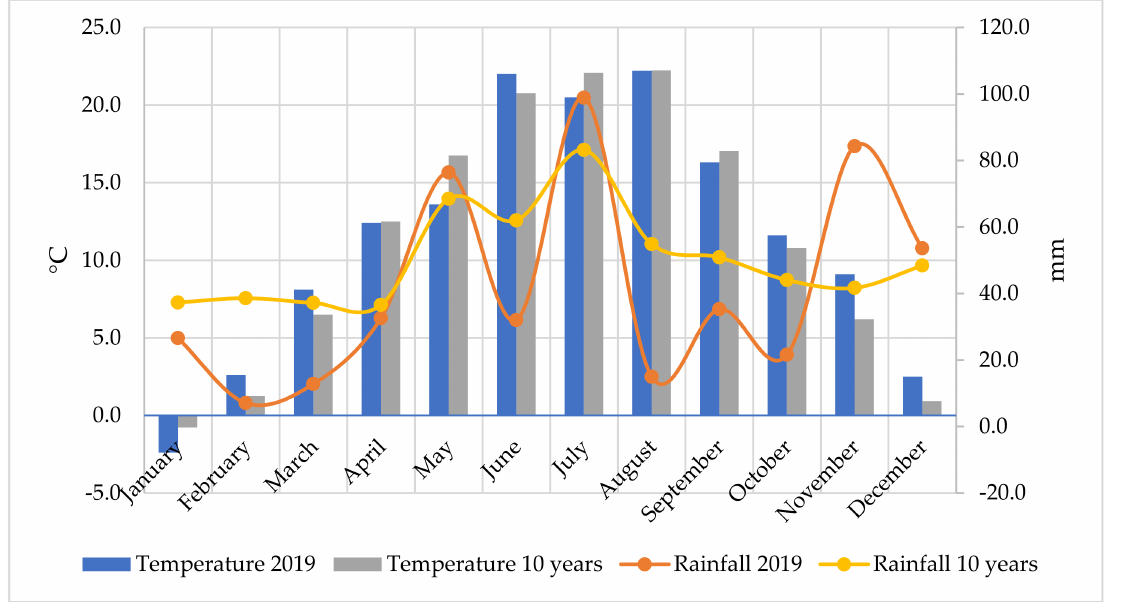
Figure 3. Temperature and precipitation data of 2019 compared to the 10-year average. Three mid-ripening maize hybrids ( Zea mays L. G1: FAO 420; G2: FAO 490; G3: FAO 390)